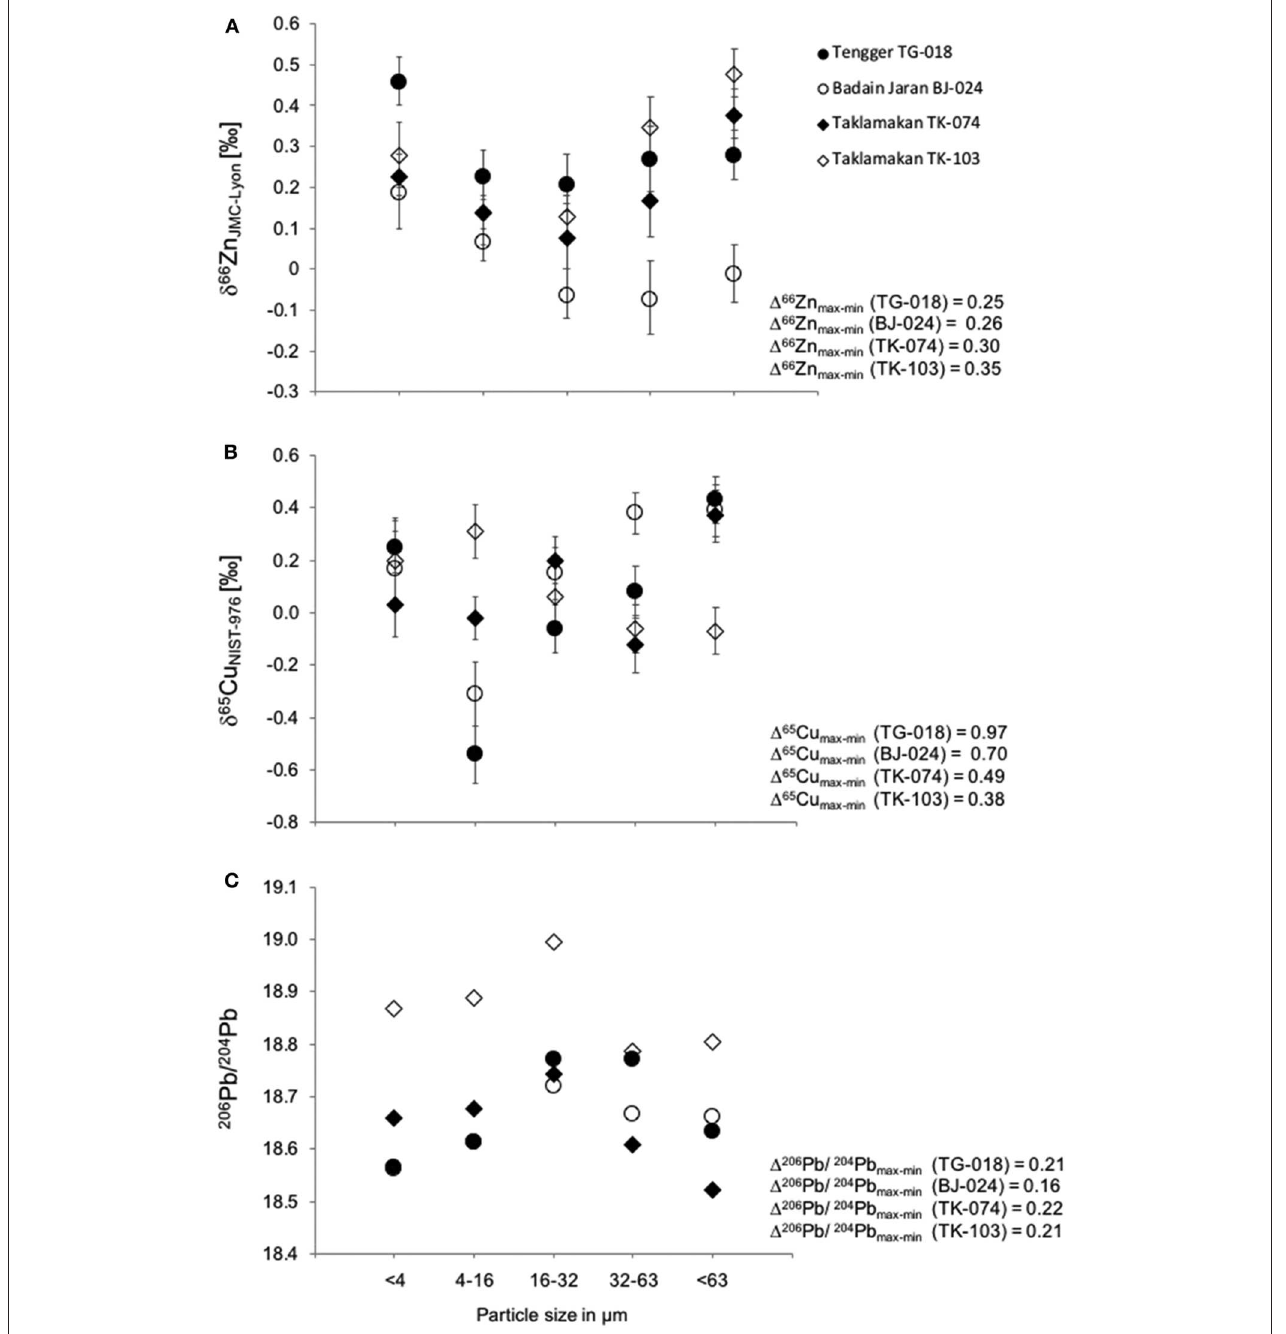
FIGURE 3 | Isotope ratios of Zn (A) , Cu (B) , and Pb (C) in the five different size fractions analyzed in four individual samples from the Tengger desert (TG-018, closed circle), Badain Jaran desert (BJ-024 open circle), and Taklimakan deserts (TK-074, closed diamond and TK-103, open diamond). Also shown are the maximum differences between highest and lowest values for each element and sample ( 1 ). The error bars for Pb are within the symbol size. Copper and Zn isotope data of TK-074 and TK-103 were published previously as a part of the validation process for our improved analytical procedure (Dong et al., 2013). Plateau (CLS-20 to − 90) and the Thar desert (TDSD-02 and − 03) and in different particle size fractions from samples from the Chinese deserts (TG-018, BJ-024, TK-074, TK-103, JY-1) to test the connection between isotopic variability and mineral phases (see also Table S2